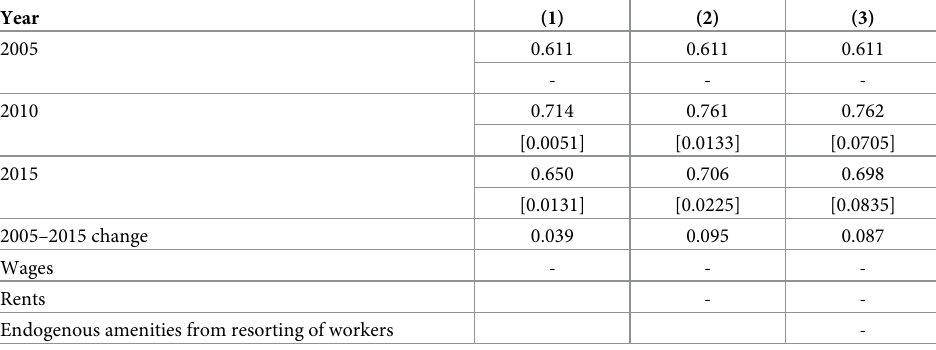
Table 9. Welfare inequality decomposition from 2005 to 2015: wages, rents, and